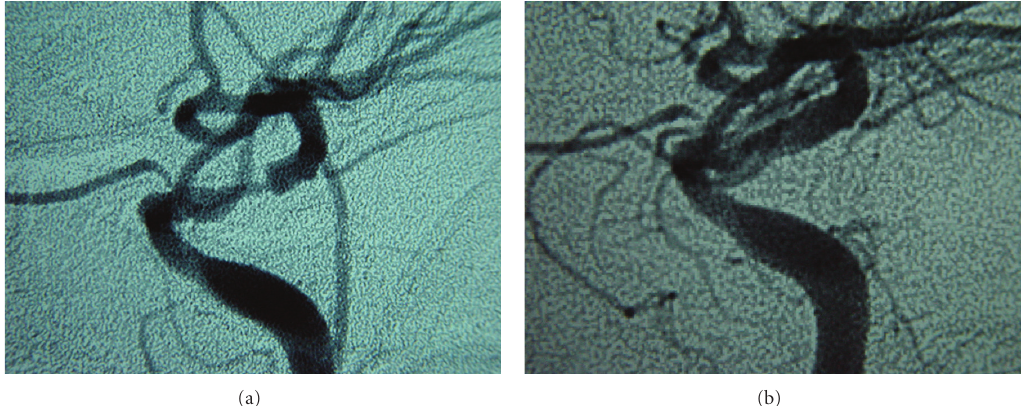
Figure 3: (a) Prestenting cerebral arteriography shows occluded terminal carotid artery; (b) Poststenting arteriography shows complete carotid